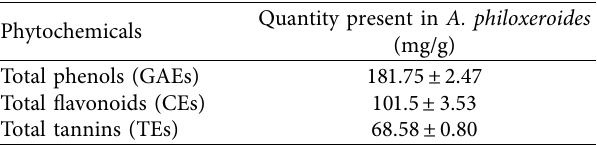
Table 1: Total phenols, flavonoids, and tannin contents in A. philoxeroides .